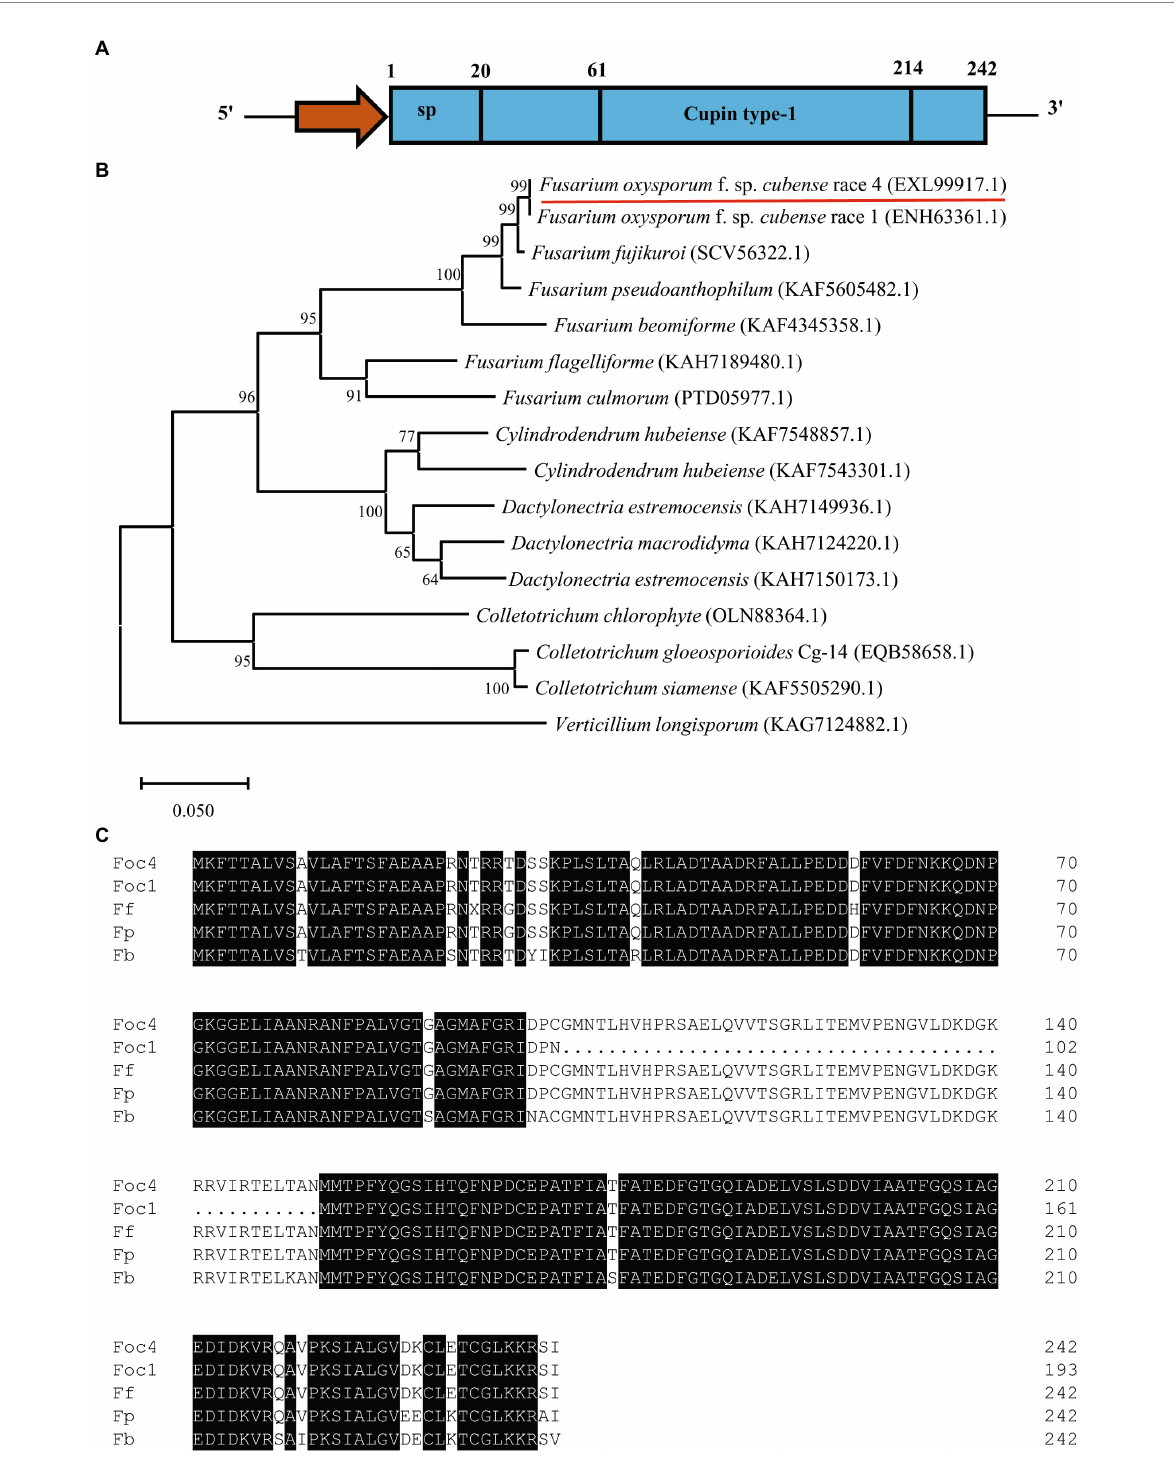
FIGURE 1 Bioinformatic analysis of FoCupin1. (A) Schematic structure of the FoCupin1 protein. The signal peptide (sp) and the domain were predicted by SignalP and Pfam, respectively. (B) Phylogenetic analysis of the FoCupin1 protein. Maximum likelihood tree was built from FoCupin1 and its orthologous proteins from 16 different fungal pathogens. (C) Amino acid sequence alignment of FoCupin1 and its homologs in other species, including Fusarium oxysporum f. sp . cubense race 1 (ENH63361.1; Foc1), F. fujikuroi (SCV56322.1; Ff), F. pseudoanthophilum (KAF5605482.1; Fp) , F. beomiforme (KAF4345358.1; Fb). The shaded dark background indicates conserved common amino acids, and the dots represent gaps in the amino acid